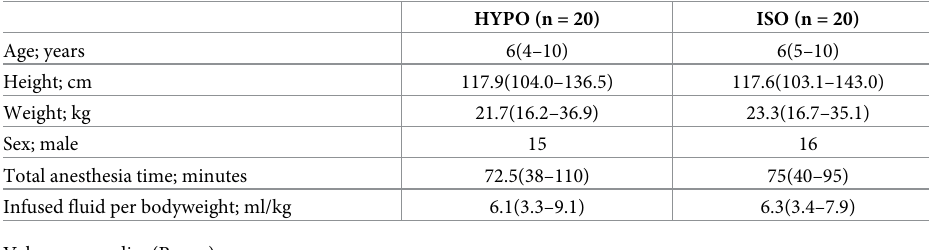
Table 2. Baseline characteristics of